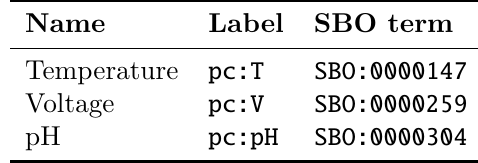
Table 2.4: A sample of values from the physical characteristics vocabulary (Section